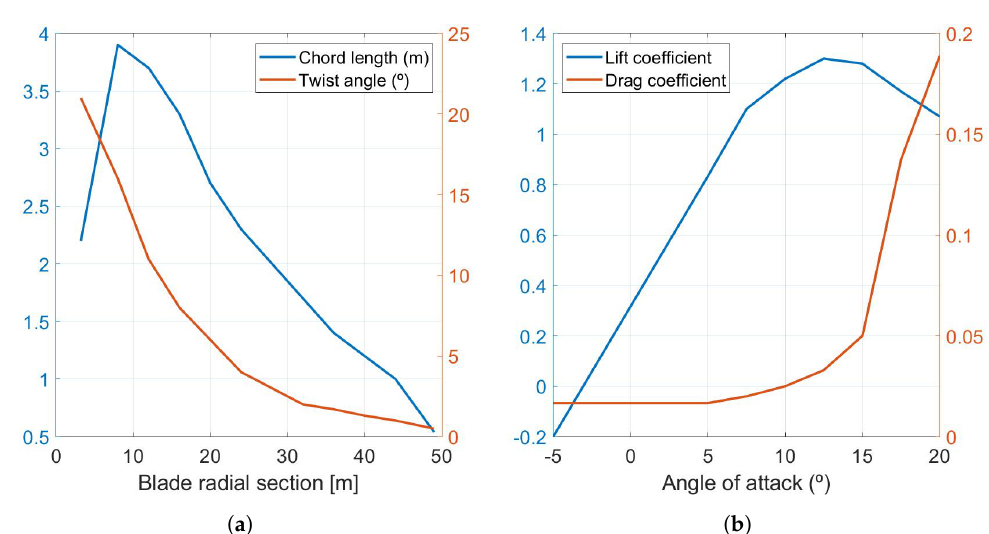
Figure 3. Actuator Line Model (ALM) chord length and twist angle distribution ( a ) and aerodynamic coefficients ( b